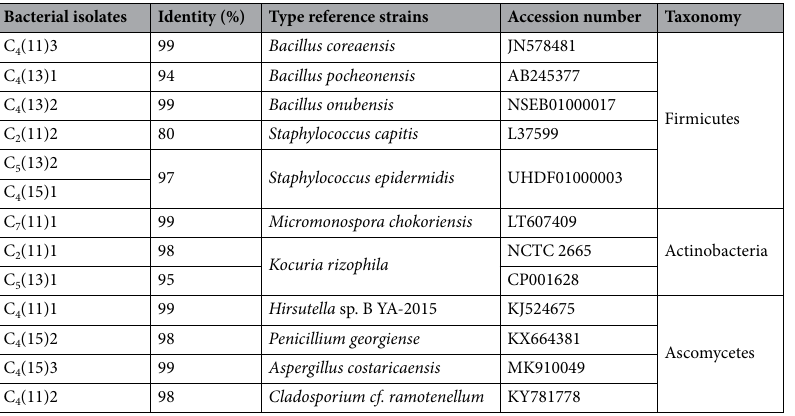
Table 3. Identification of bacterial and fungal strains isolated from the four Kinkarakawa-gami analysed. C n ( X ) m : C n indicates the chosen sampling point, as depicted in Fig. 1; X the catalogue number of the wallpaper from which the bacteria and/or fungi were isolated; m represents the number of bacterial or fungal isolates